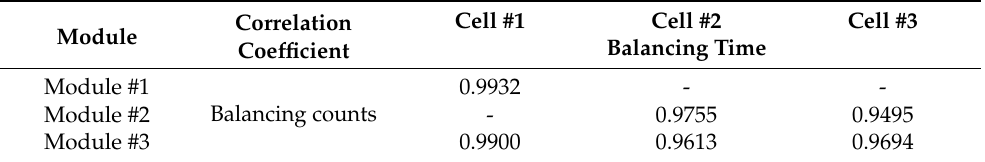
Table 9. Correlation coefficient between balancing time and balancing